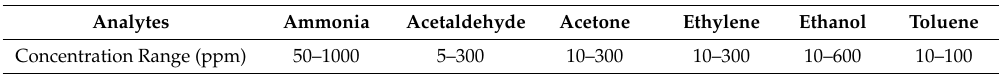
Table 3. Eight kinds of features extracted from the original response data for each sensor make up a 128-dimensional feature vector (16 sensors × 8 features). In total, 10 batches of sensor features are collected at different time intervals. The details of the sensor batches are presented in Table 4. Table 3. Concentration ranges of analytes in Dataset II.